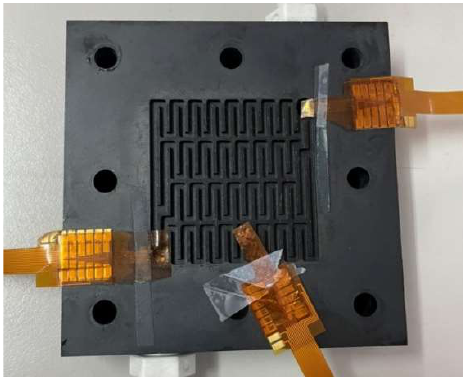
Figure 15. Position of the flexible 7-in-1 microsensor embedded in the hydrogen/vanadium redox battery.